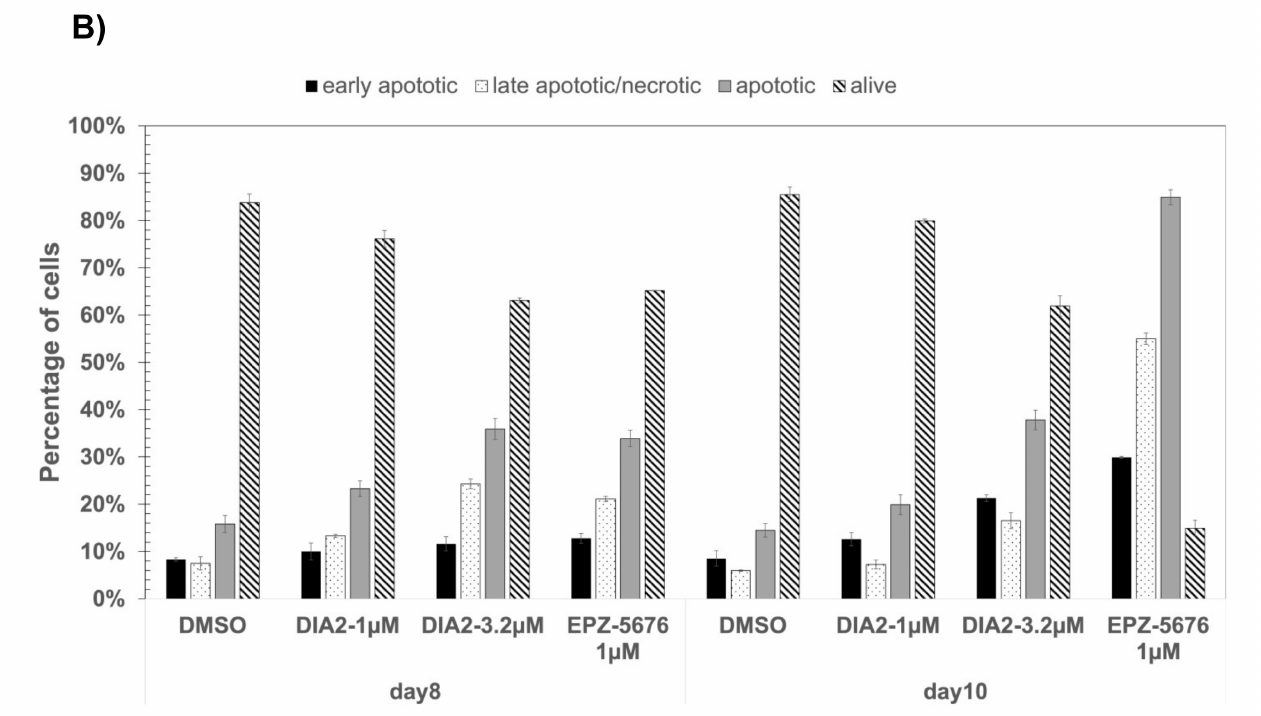
Figure 9. Cell cycle and apoptosis analysis of MV4-11 cells treated with Dia2 . MV4-11 cells with 1 µ M or 3.2 µ M Dia2 and 1 µ M EPZ-5676. The effect on the cell cycle ( A ) and apoptosis ( B ) over time was measured by staining for DNA content and Annexin V using flow cytometry. Cells treated with an equal concentration of DMSO were used as negative controls. The error bars indicate the difference between the two replicates in the